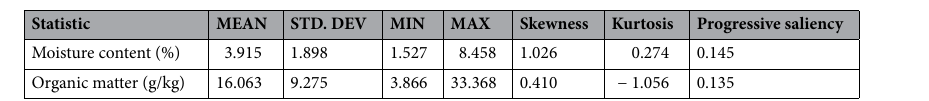
Table 2. Water content and organic matter statistical